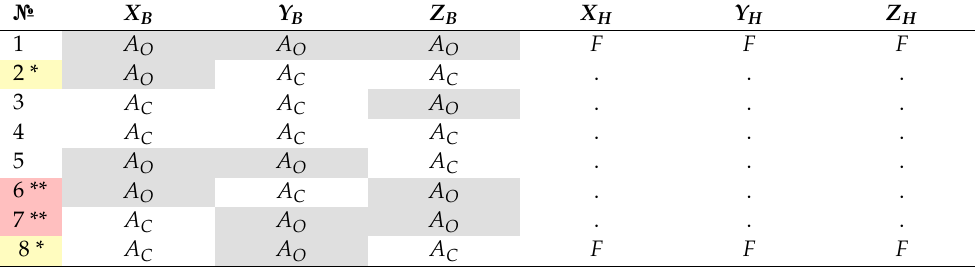
Table A4. Fixed axes X B , Y H , Z B and actuated axes X H , Y B , Z H . № X B Y B Z B X H Y H Z H 1 F A O F A O F A O 2 . A C . A O . A C 3 . A C . A C . A O 4 . A C . A C . A C 5 . A O . A O . A C 6 . A C . A O . A O 7 . A O . A C . A O 8 F A O F A C F A C Table A5. Fixed axes X B , Y H , Z H and actuated axes X H , Y B , Z B . № X B Y B Z B X H Y H Z H 1 F A O A O A O F F 2 . A C A C A O . . 3 . A C A O A C . . 4 . A C A C A C ) . . 5 . A O A C A O . . 6 . A C A O A O . . 7 . A O A O A C . . 8 F A O A C A C F F Table A6. Fixed axes X H , Y H , Z B and actuated axes X B , Y B , Z H . № X B Y B Z B X H Y H Z H 1 A O A O F F F A O 2 * A O A C . . . A C 3 A C A C . . . A O 4 A C A C . . . A C 5 A O A O . . . A C 6 ** A O A C . . . A O 7 ** A C A O . . . A O 8 * A C A O F F F A C Table A7. Fixed axes X H , Y H , Z H and actuated axes X B , Y B , Z B . № X B Y B Z B X